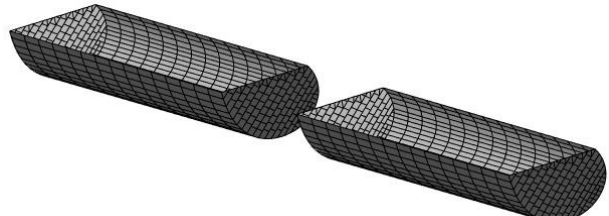
Fig. 2. A section of the discretised mesh used to compute the hydrodynamic forces that act on the submerged part of the ten duck